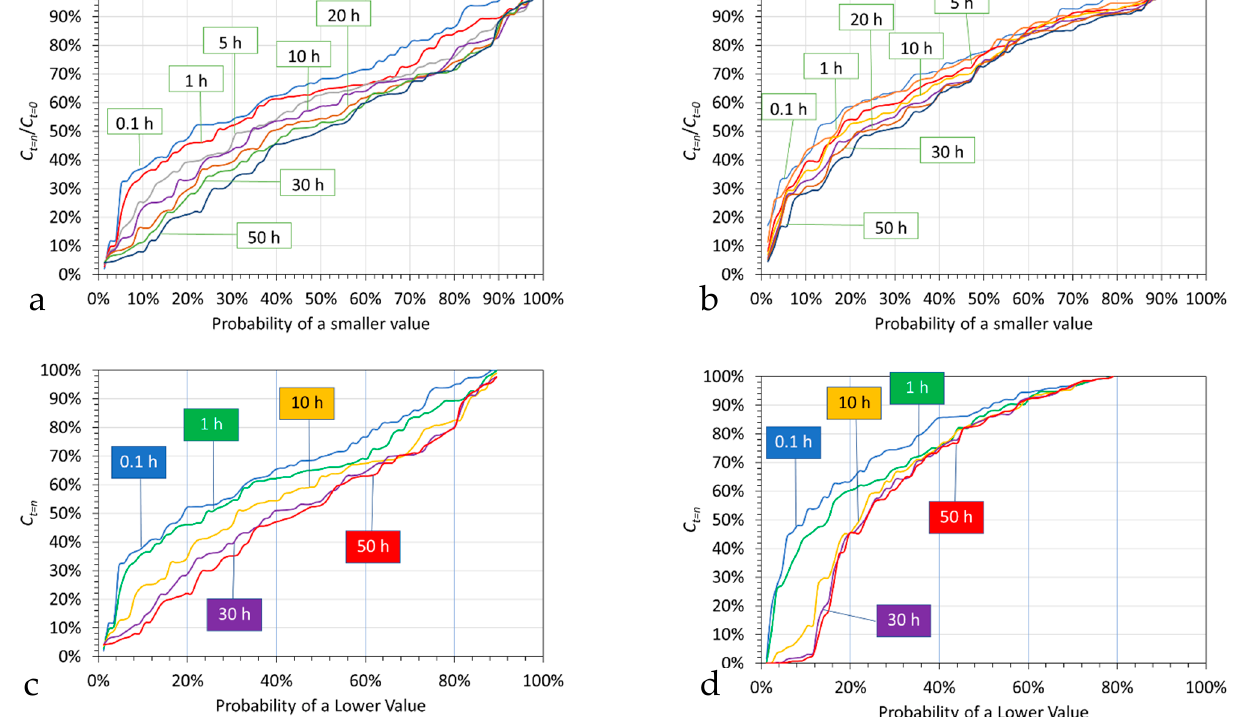
Figure 5. Probability of a smaller value versus C t = n / C t =0 as a function of reaction time, hours. ( a ), Chloride ion (only results showing chloride removal considered). ( b ), Sodium ion (only results showing sodium ion removal considered). ( c ), Chloride ion (all results considered). ( d ), Sodium ion (all results considered). Data: Supplementary Information, Tables S1 and S2.